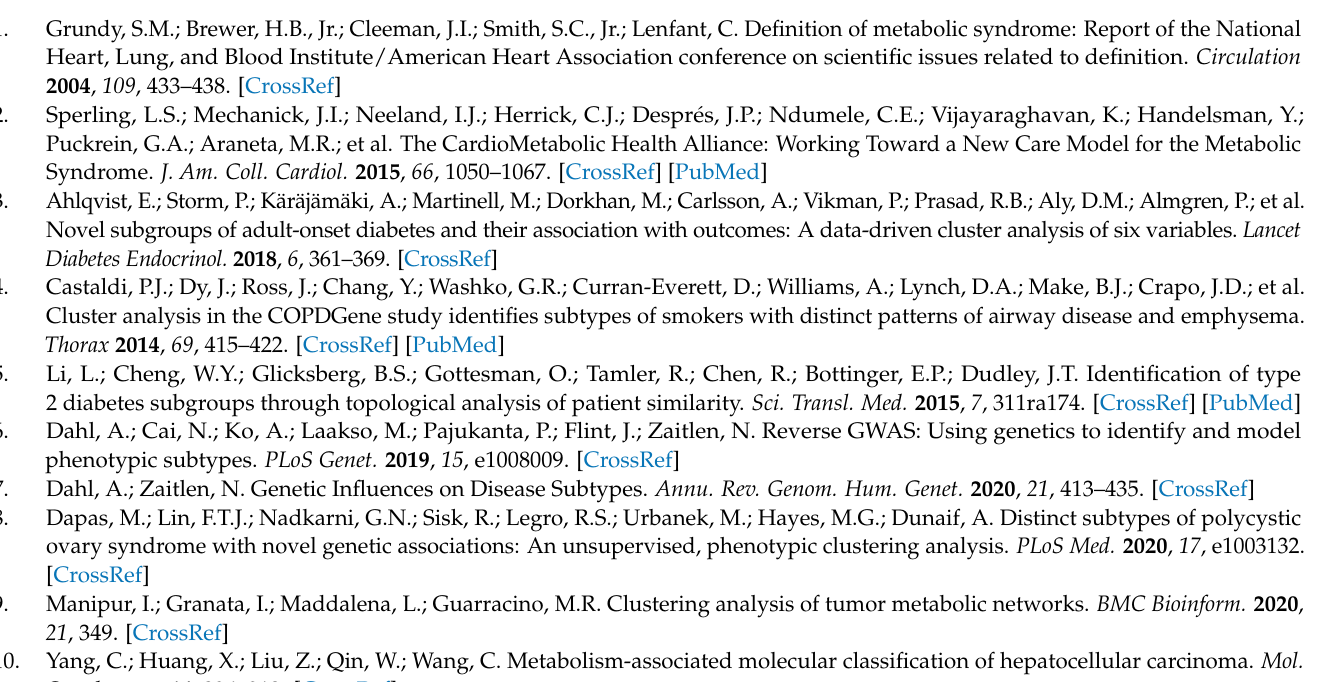
Table S6: GTEx tissue-specific enrichment analysis for the metabolic